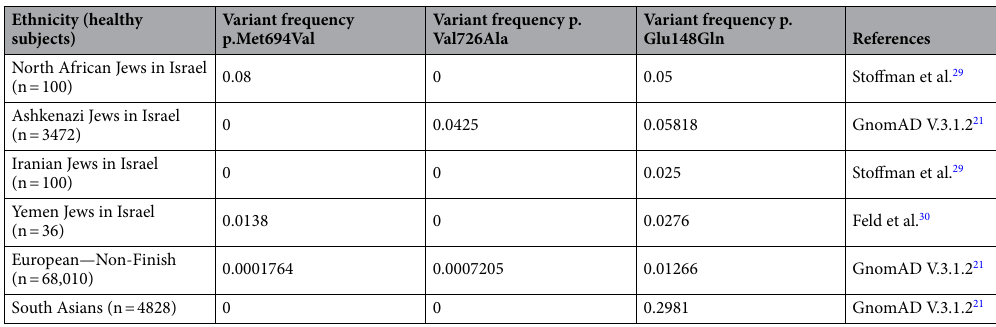
Table 2. Frequency of the p.Met694Val , p.Val726Ala and p.glu148Gln variants in Jewish and corresponding geographic non-Jewish